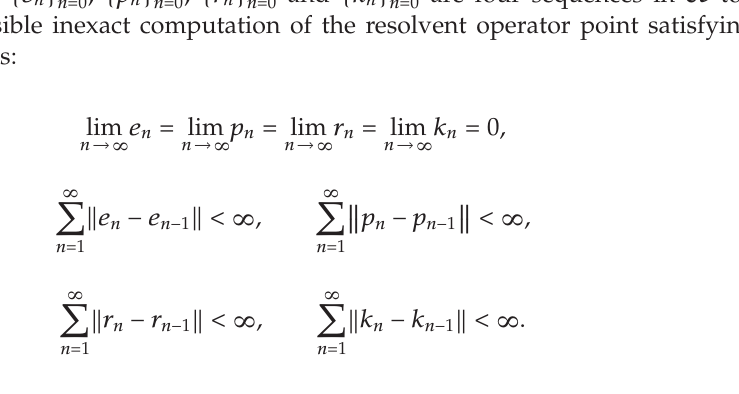
Algorithm 4.4. Let T i , g i , h i (cid:4) i (cid:8) 1 , 2 (cid:5) , ρ , and η be the same as in the system (cid:4) 3.6 (cid:5) such